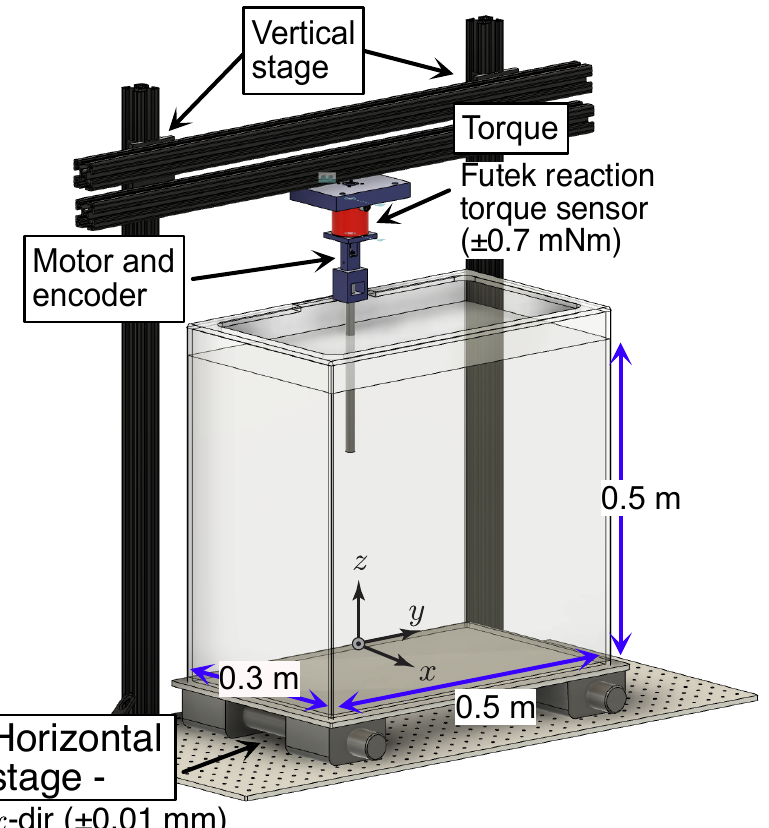
Figure 5. Experimental setup showing the tank, translation stage, torque sensor, and a cylinder positioned for measurement. The motor and magnetic encoder were housed inside a 3D-printed structure that was mounted to the active side of the torque sensor. Signal wires were run through the center of the torque sensor for motor control and data